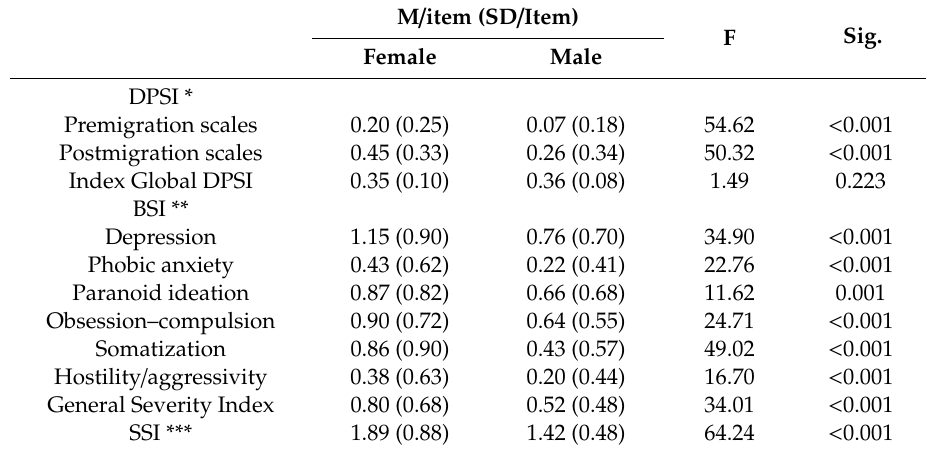
Table 3. Mean and standard deviation of the subscales of the questionnaires and comparison by gender. M / item (SD / Item) F Sig. Female Male DPSI * Premigration scales 0.20 (0.25) 54.62 <